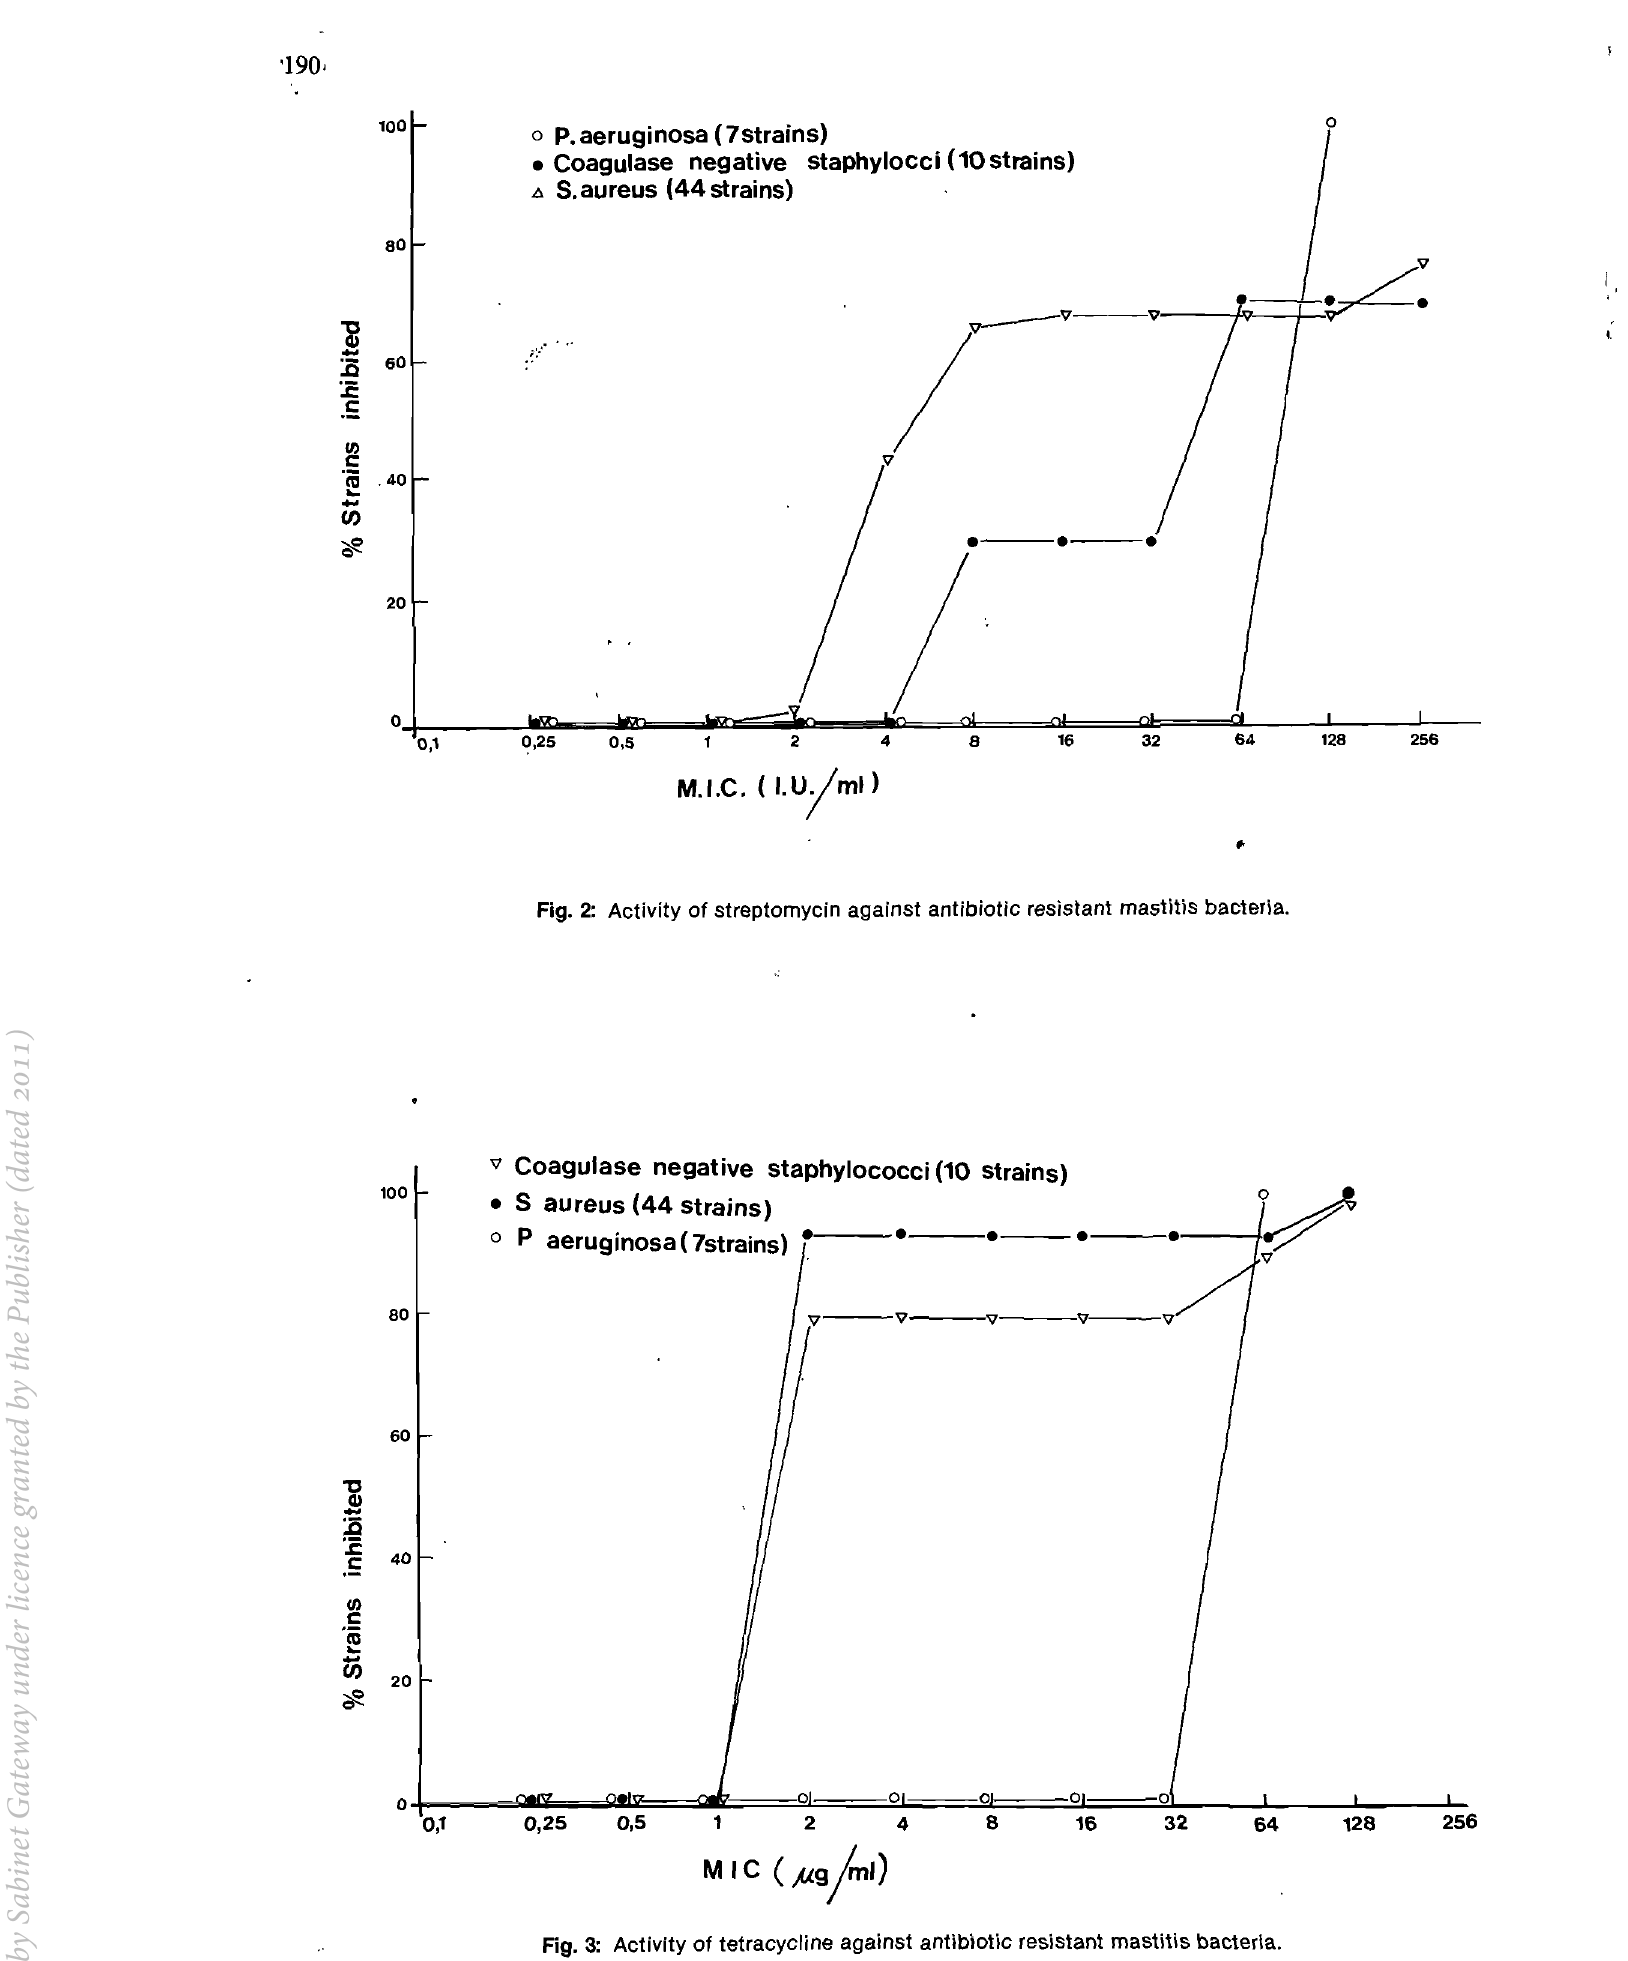
Fig, 3: Activity of tetracycline against antibiotic resistant mastitis